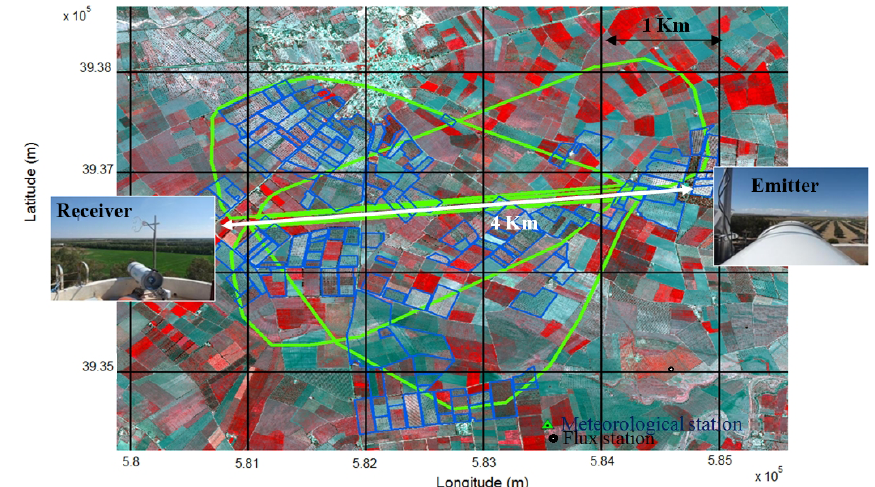
Figure 2. XLAS setup: XLAS transect (white), for which the emitter and the receiver are located at the extremity of each white arrow; half-hourly XLAS footprint for selected typical wind conditions (green); MODIS grid (black); orchards (blue); and the location of the Ben Salem meteorological and flux stations. Background is a three-color (red, green, blue) composite of SPOT5 bands 3 (NIR), 2 (VIS-red) and 1 (VIS-green) acquired on 9 April 2013 and showing in red the cereal